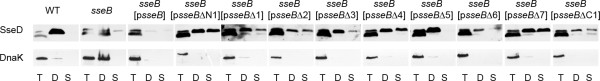
Effect of various deletions in sseB on secretion and partitioning of SseD in vitro. S. Typhimurium WT or ΔsseB without plasmid, harboring plasmid psseB for complementation of the sseB deletion, or plasmids for the expression of various sseB mutant alleles (psseBΔx) were grown and analyzed as described for Fig. 2, but SseD was detected using a polyclonal antiserum raised against recombinant SseD. For the cytosolic portion of SseD, we observed a lower molecular weight form in addition to the protein found in the secreted fraction. The quantification of the signal intensities is shown in Additional file 1.